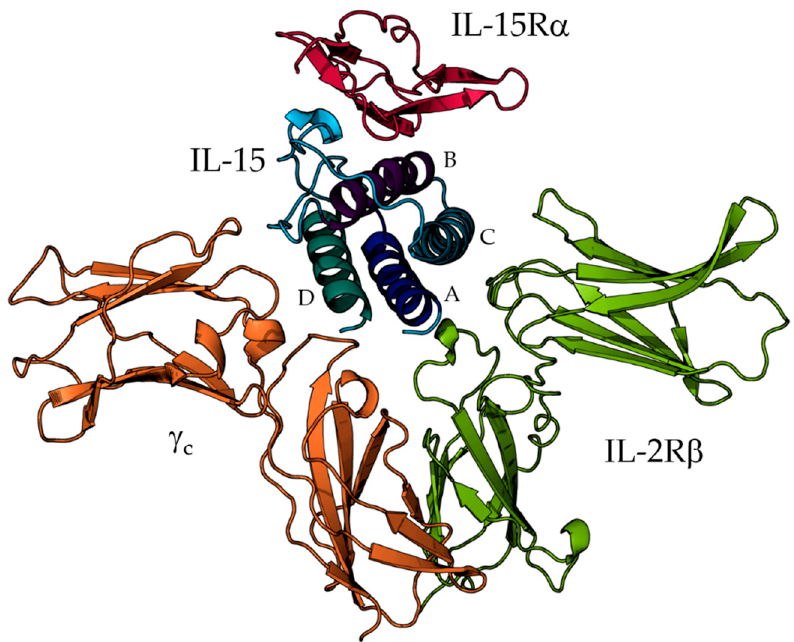
Figure 1. Structure of IL-15 in the full (IL-15 / IL-15R α / IL-2R β / γ c ) form. IL-15 is colored in blue and the A-D helices are indicated, IL-15R α in magenta, IL-2 β in green and γ c in orange.